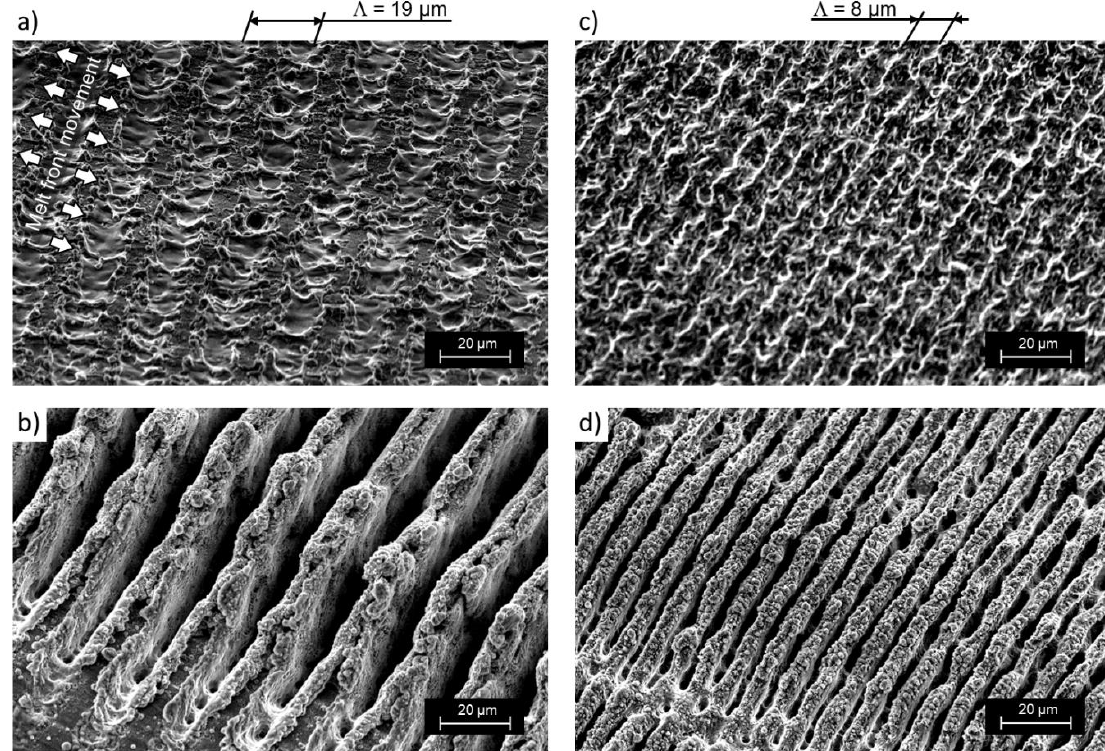
Figure 2. Scanning electron microscope images of DLIP structured aluminum surfaces with interference periods of ( a , b ) Λ = 19.0 µm and ( c , d ) Λ = 8.0 µm, fabricated using pulse overlaps ( a , c ) pulse overlap (PO) = 80% and ( b , d ) PO = 99%. The laser fluence was 3.2 J∙cm −2 . Material: aluminum EN AW-5754 AlMg3 [43].